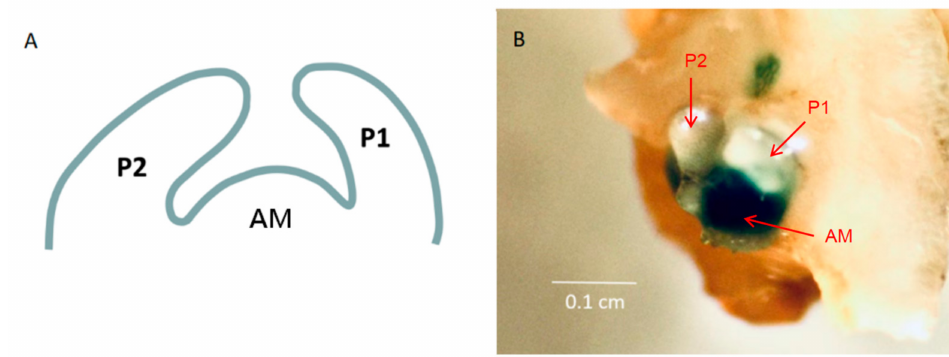
Figure 7. GUS staining results of CmSTM gene promoter of chrysanthemum (( A ) is the schematic diagram of axillary bud structure, and ( B ) is the GUS staining results of an axillary bud of transgenic tobacco; P1 represents the first leaf primordium, P2 represents the second leaf primordium, and AM represents the axillary